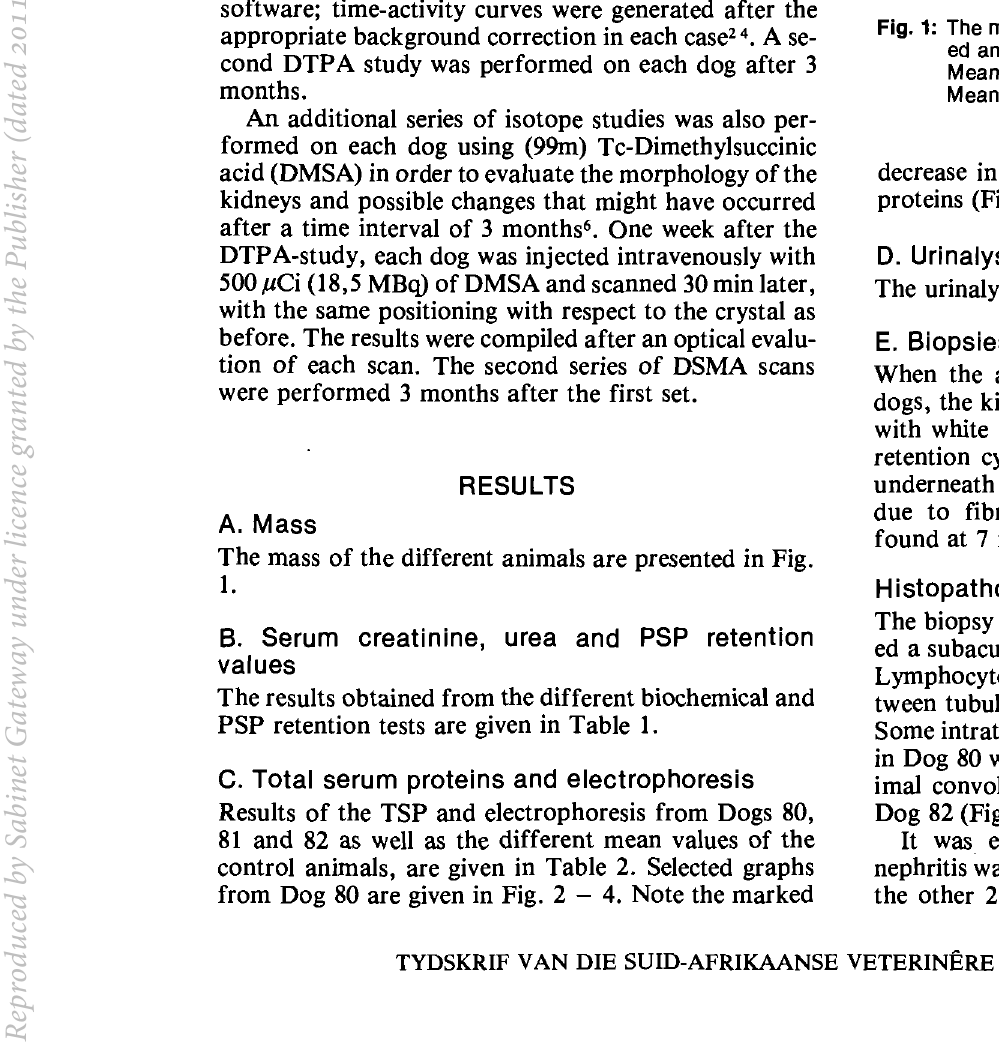
Fig. 1: The mass of control dogs is compared to the 3 diseas· ed animals Mean male controls ••••••• Dog 80 (female) .... . Mean female controls ._._._ Dog 81 (male) ............. . Dog 82 (female)